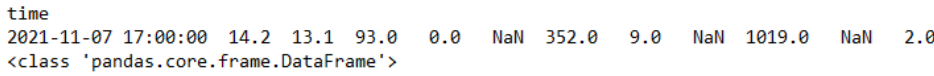
Figure 5. Returned data from Meteostat for a given latitude, longitude, timestamp, and altitude.